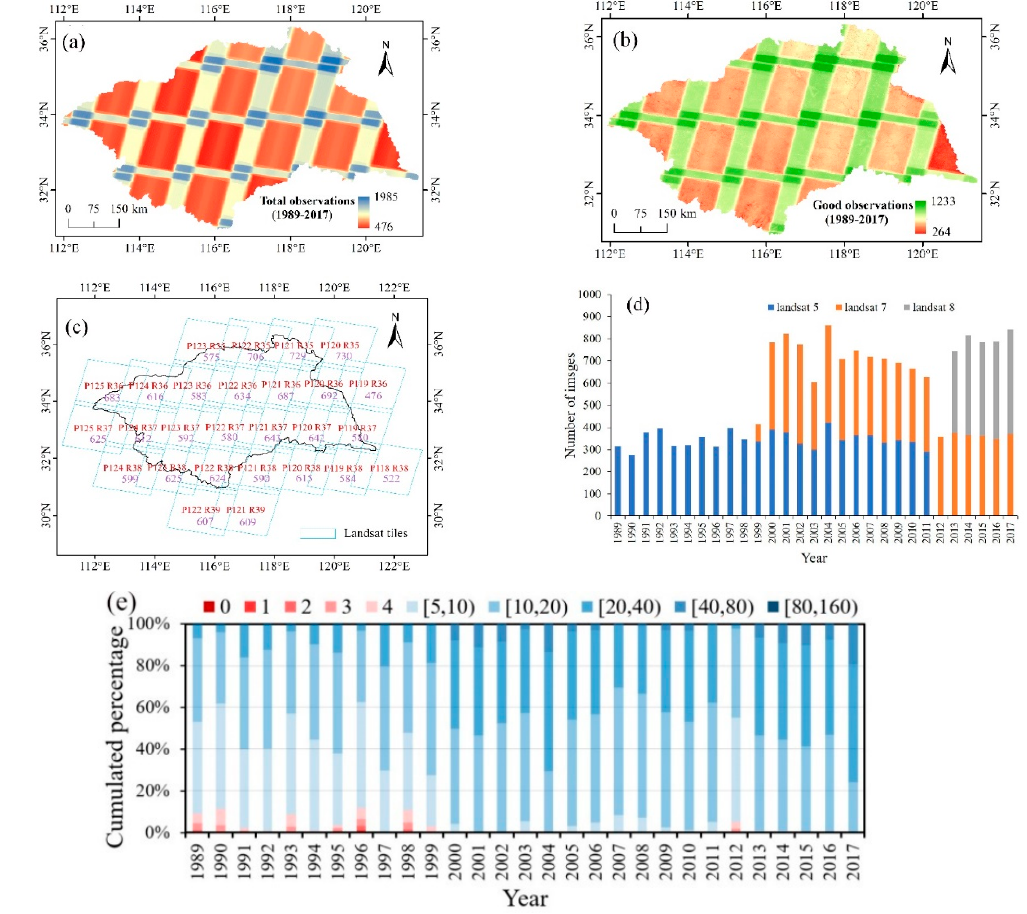
Figure 2. The numbers distribution of Landsat 5, 7, 8 images in Huai River Basin from 1989 to 2017: ( a ) The total numbers of Landsat observation; ( b ) the total number of high-quality Landsat images; ( c ) the total number of Landsat images in each path/row (tiles); ( d ) the total number images of different Landsat sensors; ( e ) Cumulative percentage of pixels with good observations of 0, 1, 2, 3, 4, [5,10), [10,20), [20,40), [40,80), [80,160), respectively during 1989–2017.